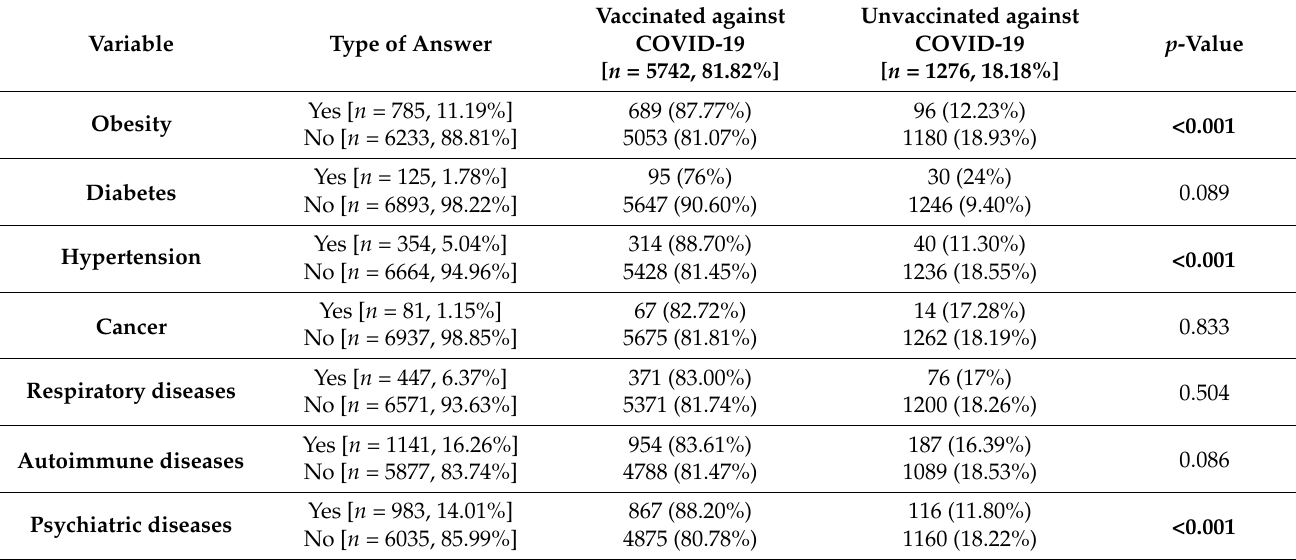
Table 2. Participants’ chronic